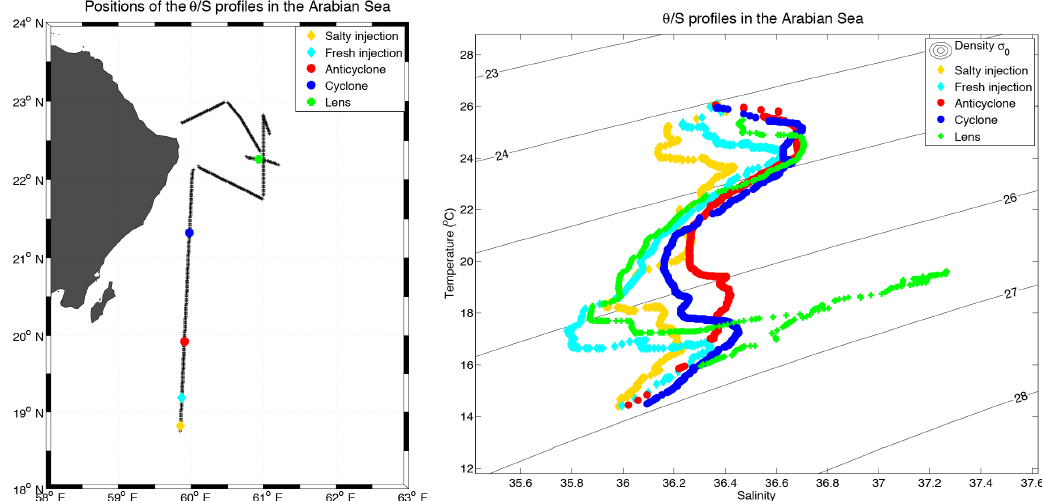
Figure 8. Potential temperature over salinity profiles (right) in the western Arabian Sea at various locations of interest (left). From north to south: yellow diamond: salty injection around anticyclone A2; cyan diamond: fresh injection around anticyclone A2; red circle: inside anticyclone A2; blue circle: inside cyclone C1; green cross: inside the lens off Ra’s Al